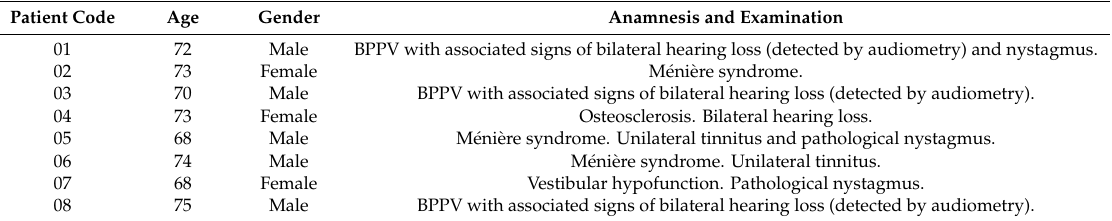
Table 1. Data of patients